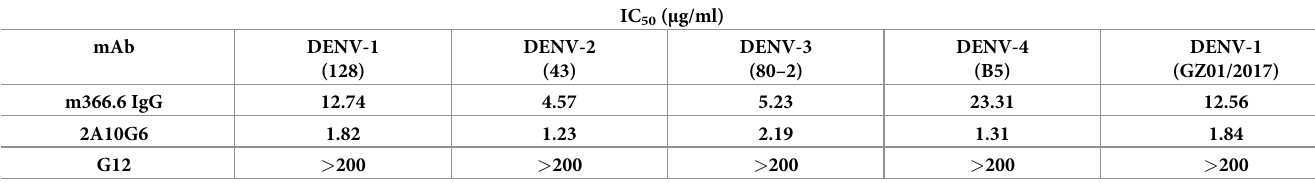
Table 2. PRNT 50 values of mAbs against DENV1-4.